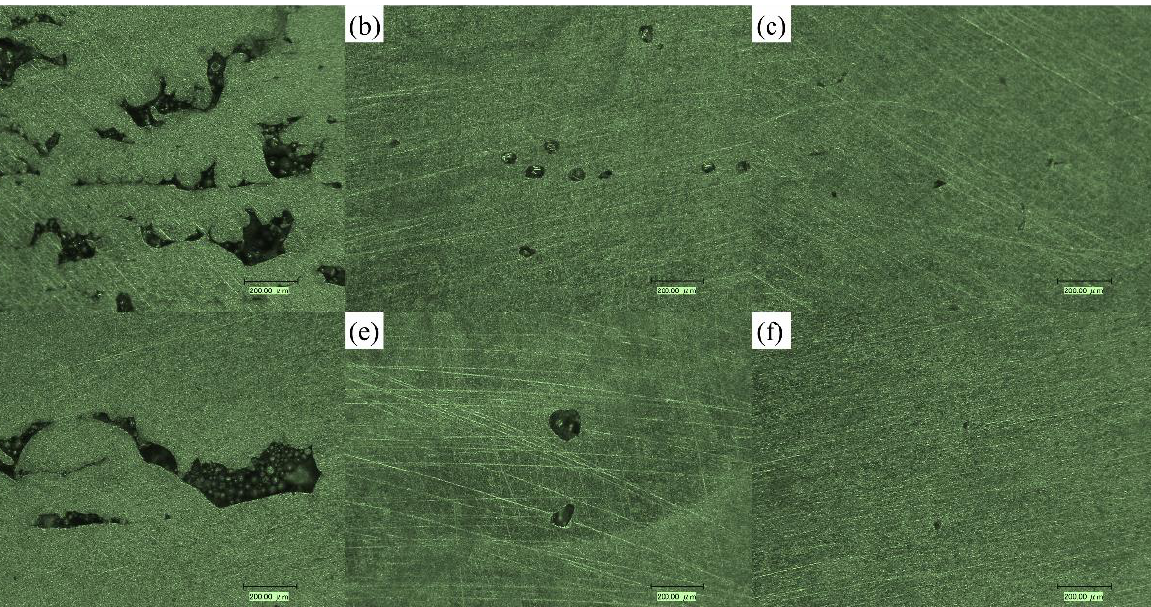
Figure 7. Internal defects of formed specimens: 50 μm: ( a ) un-melted, ( b ) porosity, ( c ) splash; 150 μm: ( d ) un-melted, ( e ) porosity, ( f ) splash.